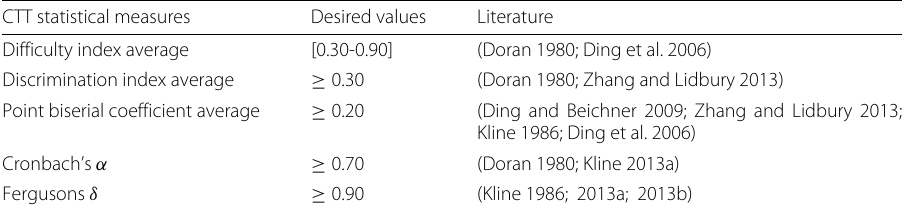
Table 3 CTT statistical measures desired values CTT statistical measures Desired